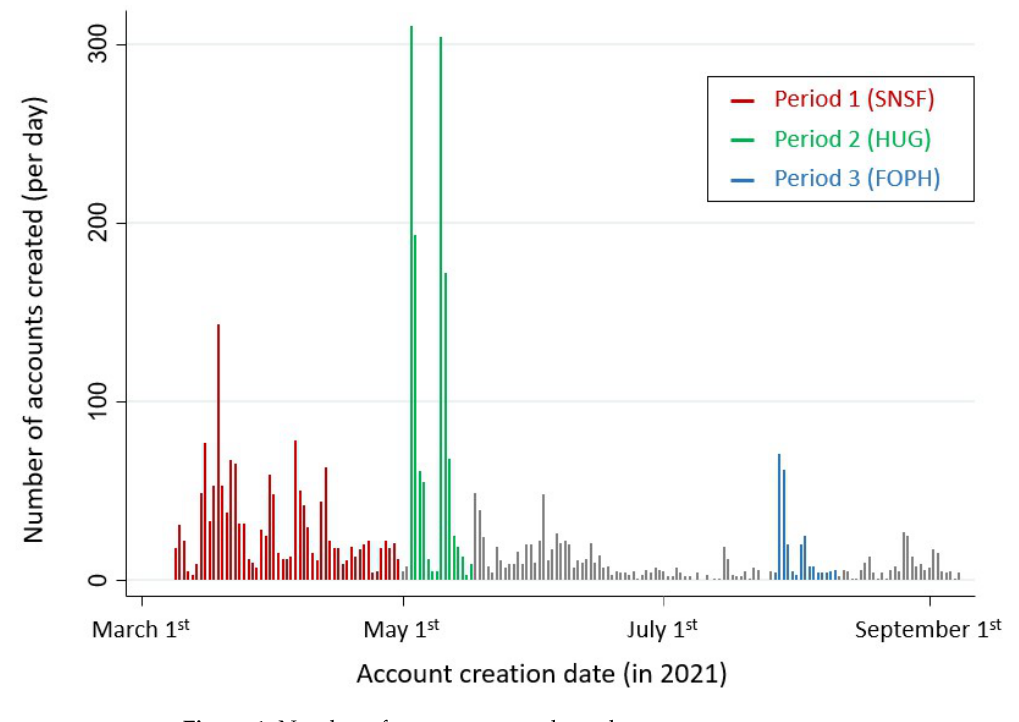
Figure 1. Number of accounts created per date.